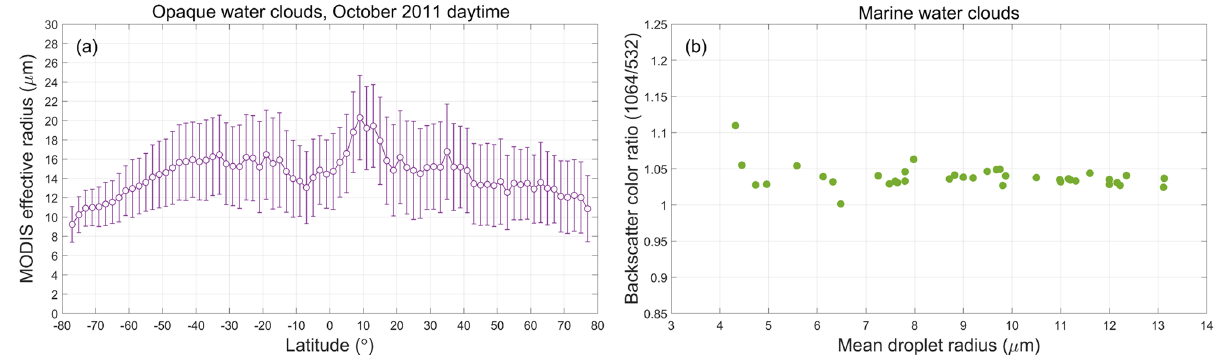
Figure 26. (a) MODIS retrievals of effective radius for opaque water clouds measured along the CALIPSO orbit track during daytime; (b) Mie calculations of backscatter color ratio (1064nm / 532nm) computed for in situ measurements of marine water clouds as a function of cloud mean droplet radius.